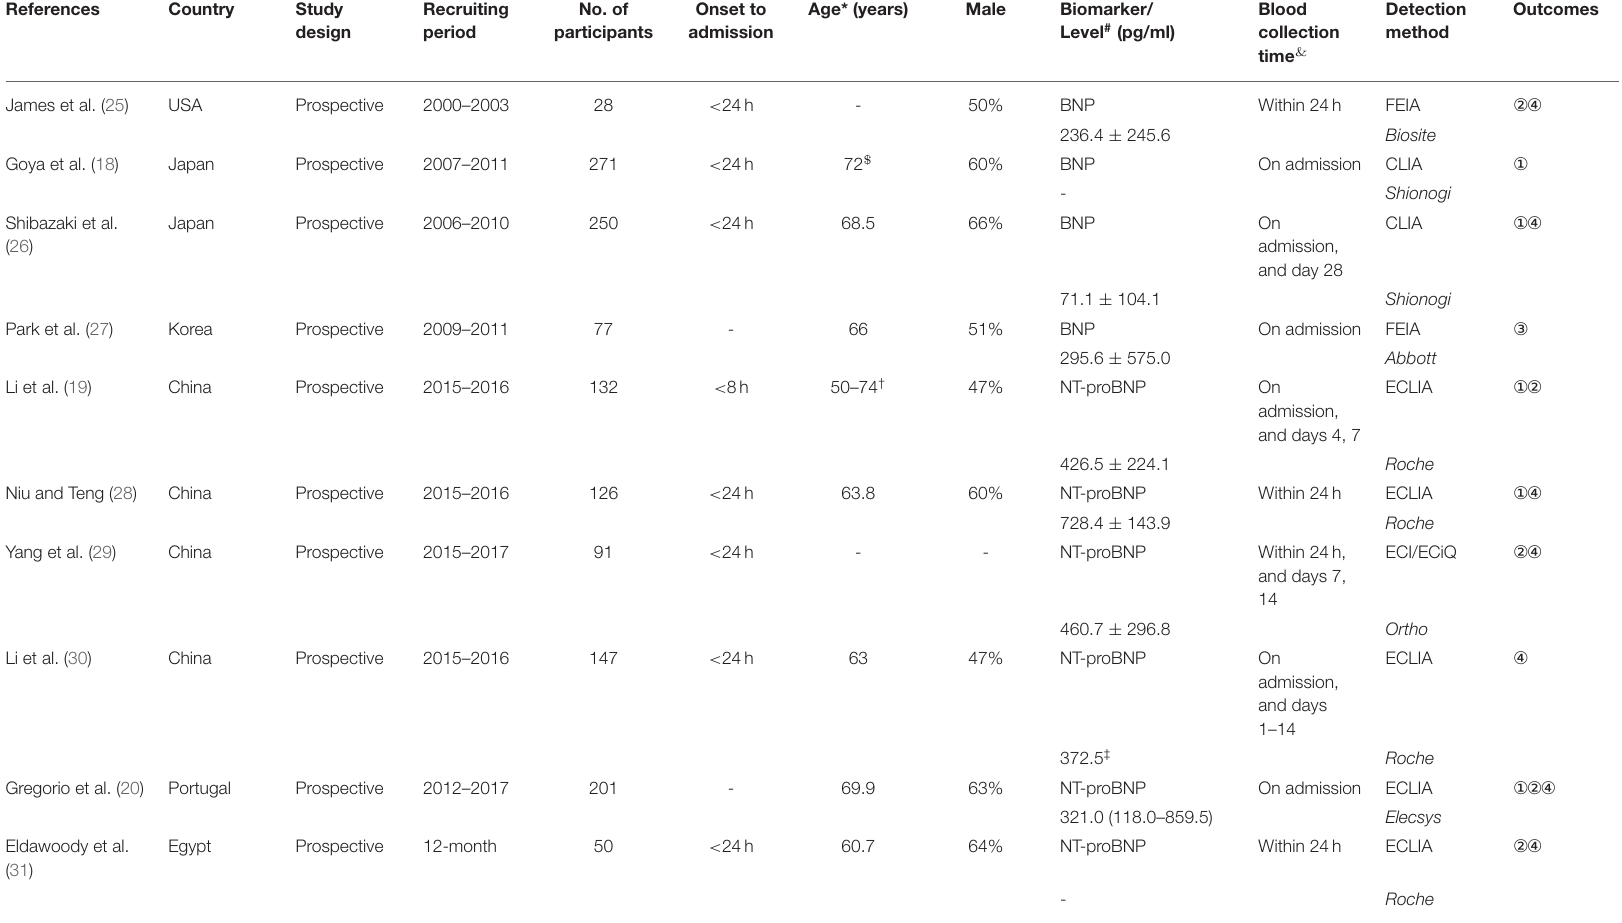
TABLE 1 | Baseline characteristics of included